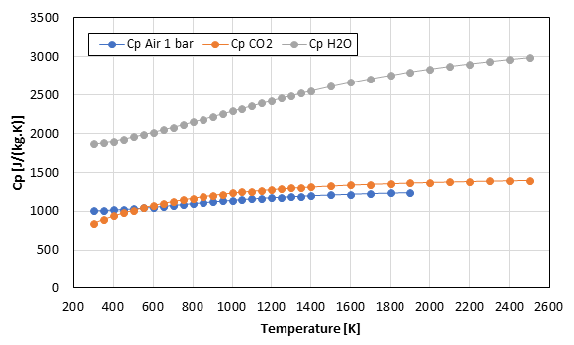
Fig. 1. Heat capacity of air, carbon dioxide and steam at constant pressure of 1